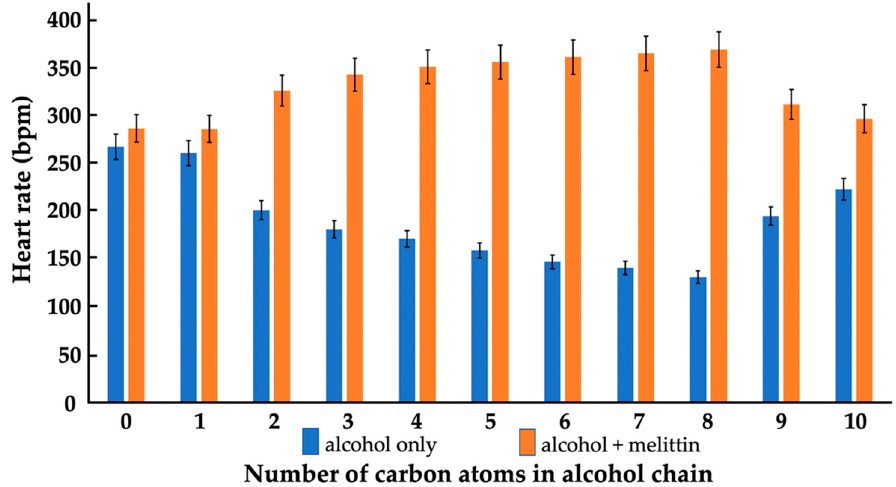
Figure 1. Heart rate of Daphnia pulex as a function of alcohol chain length in the absence of melittin and in melittin-treated organisms. The heart rate was measured in beats per minute (bpm). Individual fleas were treated with either alcohols, melittin or a mixture of alcohol and melittin as described in the Materials and Methods. Concentrations of alcohols and melittin were 1.65 × 10 − 3 M and 1.65 × 10 − 4 M, respectively. Blue and orange bars at 0 on the horizontal axis show, respectively, the heart rates of the control sample and sample treated with melittin in the absence of alcohol. Data points represent mean values from at least three independent experiments on different fleas. The standard deviations shown in error bars were within 5.0% of the means.